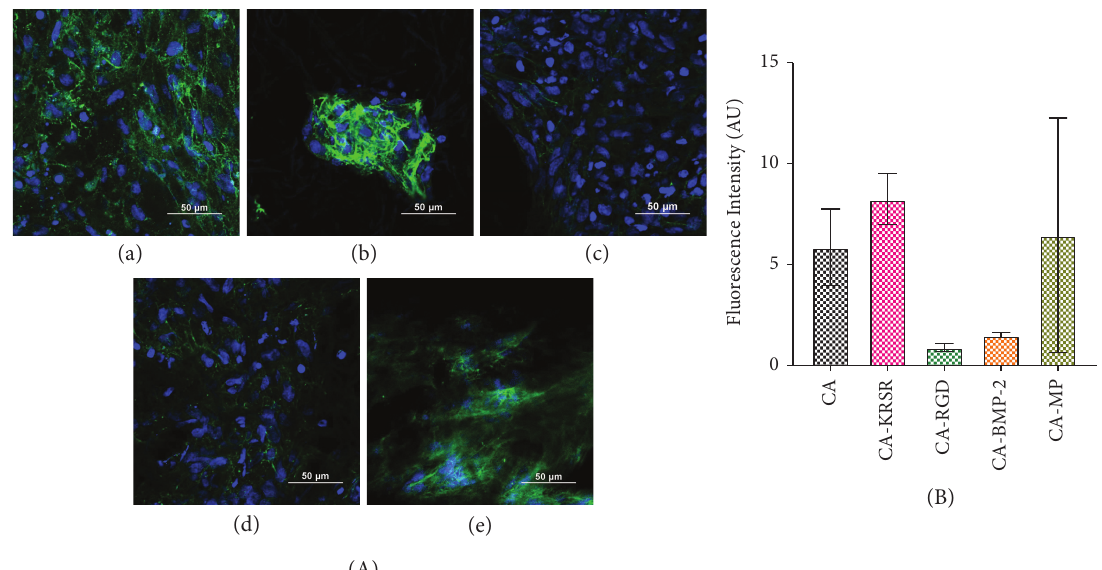
Figure 6: (a) Collagen I (green) assay for hFOB 1.19 (blue nuclei) across each CA electrospun mat. (A) CA Fiber mat, (B) CA-KRSR, (C) CA-RGD, (D) CA-BMP-2, and (E) CA-MP. Scale bar represents 50 µ m. (b) Alexa Fluor 488 Fluorescence Intensity plot normalized by the number of cells for collagen expression. Error bars represent the standard error of the mean.